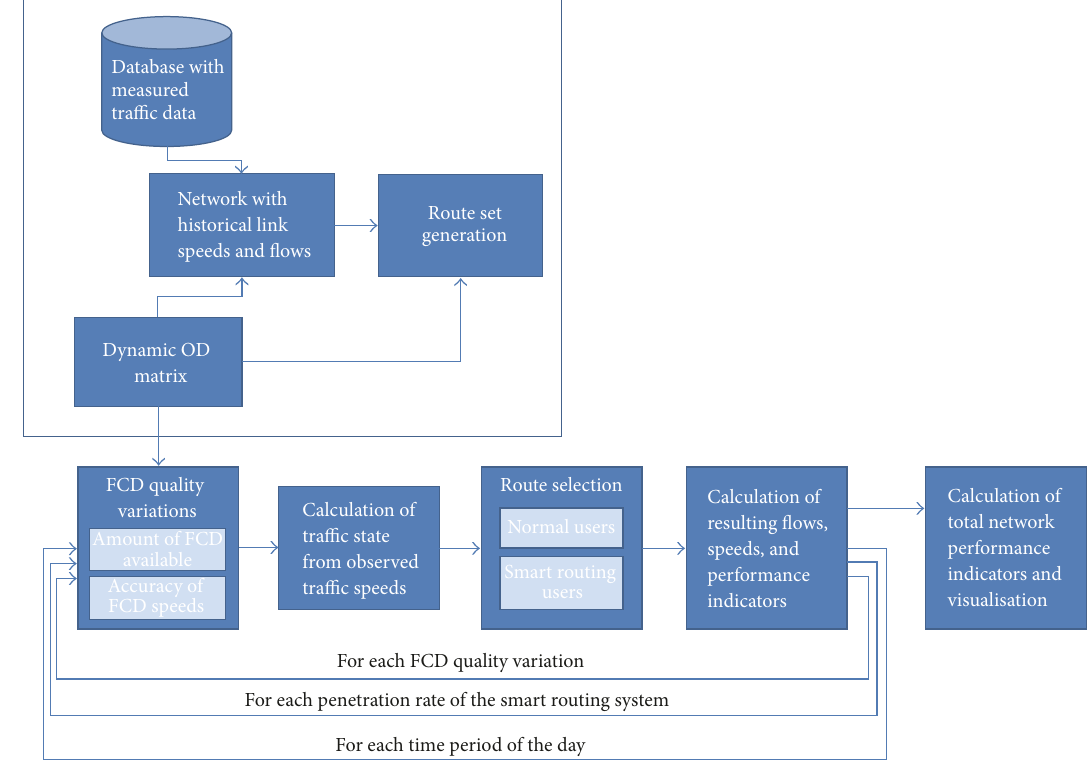
Figure 1: Modelling approach for the smart routing case study.